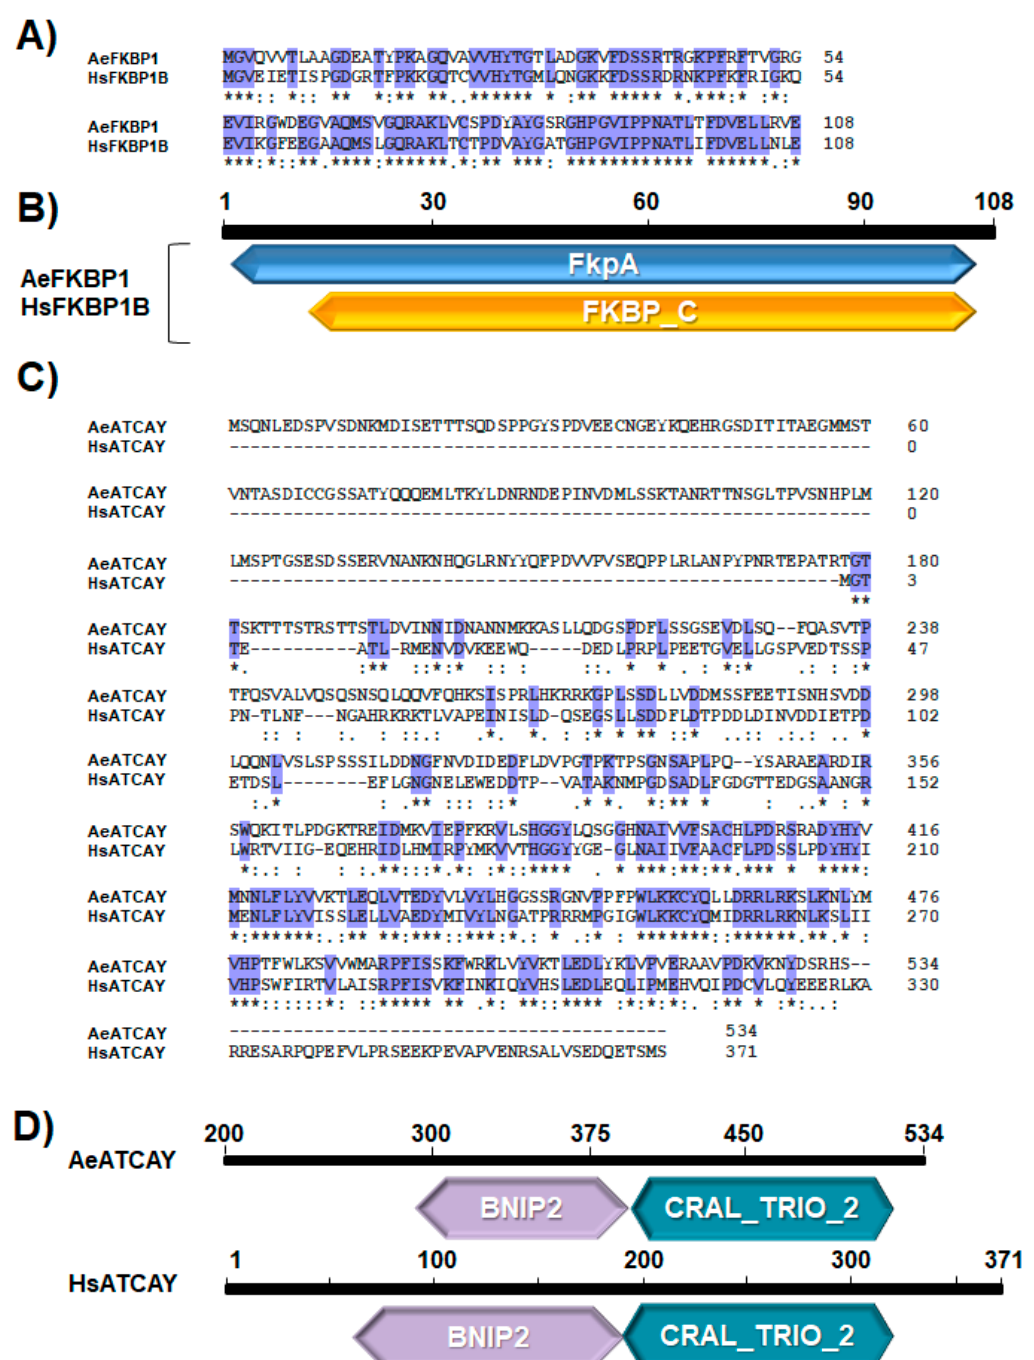
Figure 2. Sequence analysis of AeFKBP1 and AeATCAY. ( A ) Pairwise sequence alignment of human FKBP1B and AeFKBP1 shows that both sequences share 72.2% and 81% amino acid identity and similarity, respectively. These two proteins consist of 108 amino acids without gaps, indicating putative functional conservation. ( B ) Comparison of protein domains using the DELTA-BLAST algorithm shows that human FKBP1B (HsFKBP1B) and AeFKBP1 share FKBP-type peptidyl-prolyl cis-trans isomerase domains. ( C ) Pairwise sequence alignment of human ATCAY (HsATCAY) and AeATCAY shows that both sequences share 48% and 69% amino acid identity and similarity, respectively. ( D ) Comparison of protein domains using the DELTA-BLAST algorithm shows that human ATCAY and AeATCAY share BNIP2 and CRAL/TRIO domains but differ in in domain length. ( A , C ) ‘*’ means fully conserved residue; ‘:’ means strongly similar properties; ‘.’ means weakly similar properties.